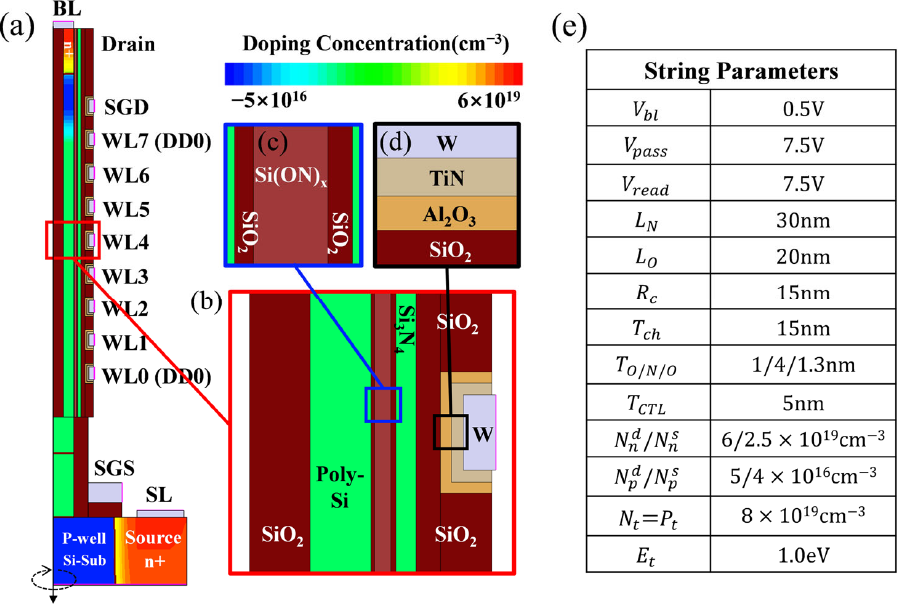
Figure 2. ( a ) Schematic cross section of a 3D NAND bitline string used in TCAD simulation. N-type and p-type doping concentrations are shown as color levels. Enlarged images of ( b ) MONOS memory cell, ( c ) tunnel oxide layer, and ( d ) block layer. ( e ) Main bitline string